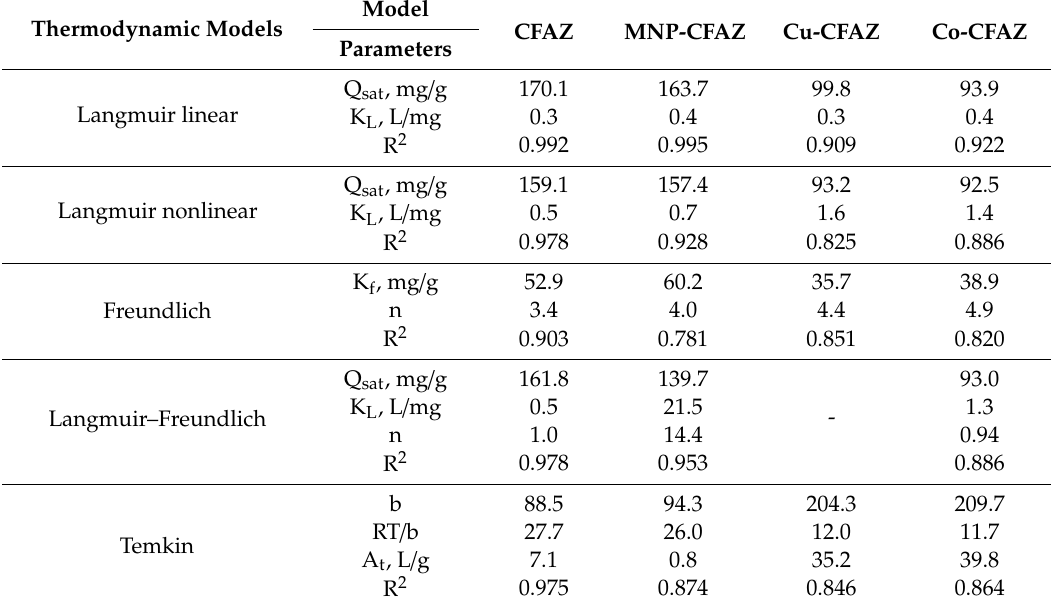
Table 3. Results from the thermodynamic model studies of the experimental isotherms for adsorption of Cd 2 +